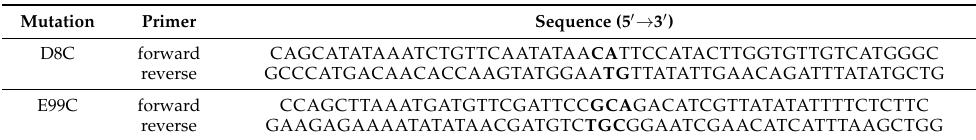
Table 4. DNA sequences of specific primers used for amino-acid substitutions in B. subtilis MntR protein. Changes in sequence are denoted in